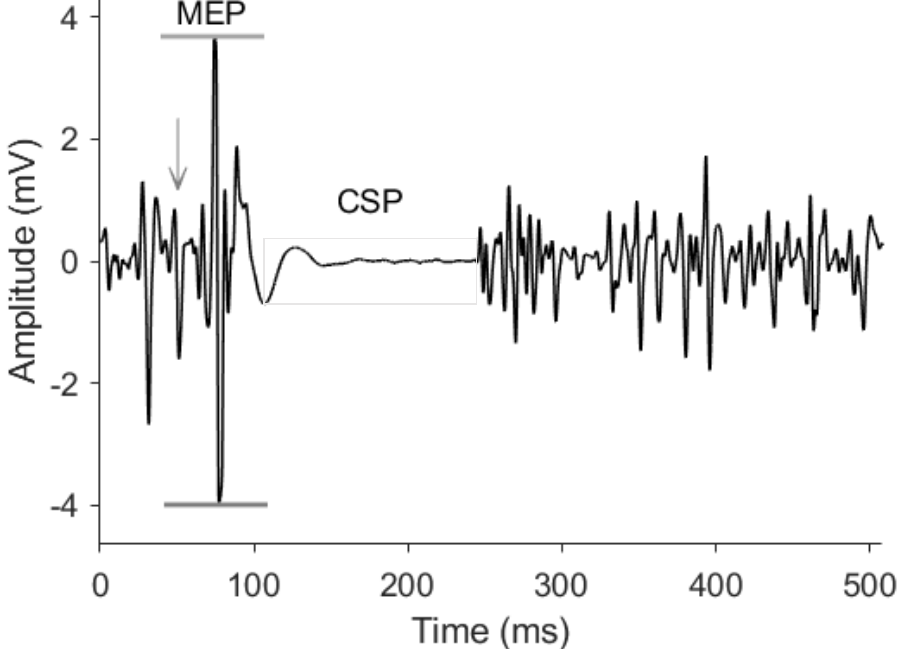
Figure 1. Sample EMG recording. Corticospinal excitability was assessed through peak-to-peak amplitude of the MEP (horizontal lines). Corticospinal inhibition was assessed through the CSP duration (shaded area). The arrow indicates the TMS stimulus artifact.